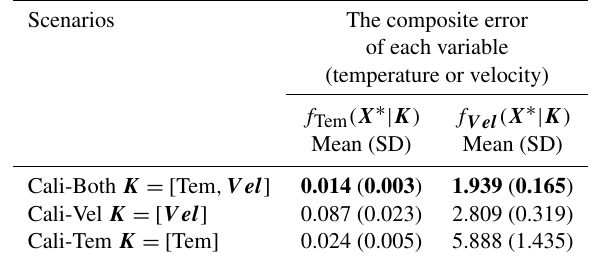
Table 4. Summary table of the solution obtained by PODS for each scenario (Cali-Both, Cali-Vel, and Cali-Tem). f Tem ( X ∗ | K ) and f Vel ( X ∗ | K ) are the temperature error f Tem ( X ∗ ) and veloc- ity error f Vel ( X ∗ ) (calculated in Eq. (7) and Eq. (10), respectively, with the optimal solution X ∗ obtained in each trial). The mean and standard deviation of f Tem ( X ∗ | K ) and f Vel ( X ∗ | K ) among three trials are reported. The variable error is bold in each scenario when the observation of the variable is included in the calibration in each scenario. (Some terms defined in Table